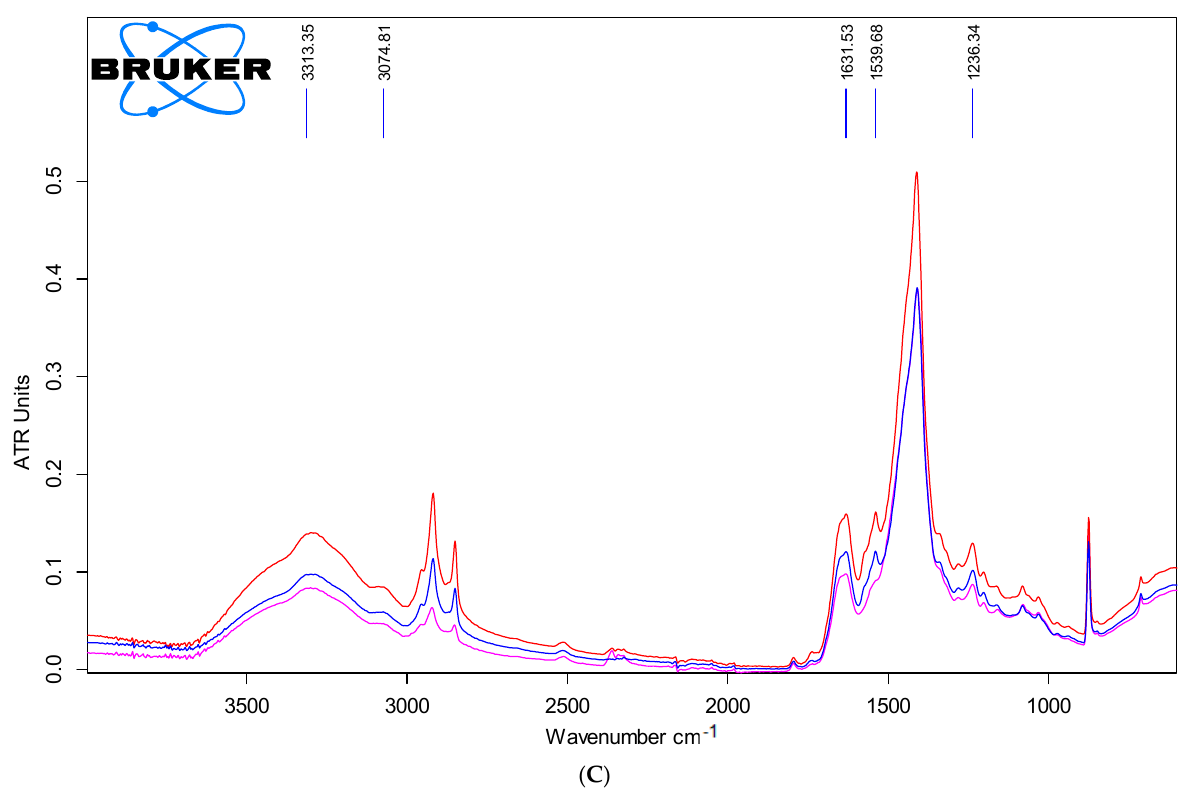
Figure 6. The ATR-FTIR spectra for parchment irradiated samples; ( A ) interval no. 1: 3–6–10 kGy; ( B ) interval no. 2: 15–20–25 kGy; and ( C ) interval no. 3: 35–50–100 kGy. Amide I band depicts modifications of the helix and random coil components, for lowest doses (blue lines) and, respectively, higher doses (red and magenta lines); increase of the right maxima of the band responsible for random structures is